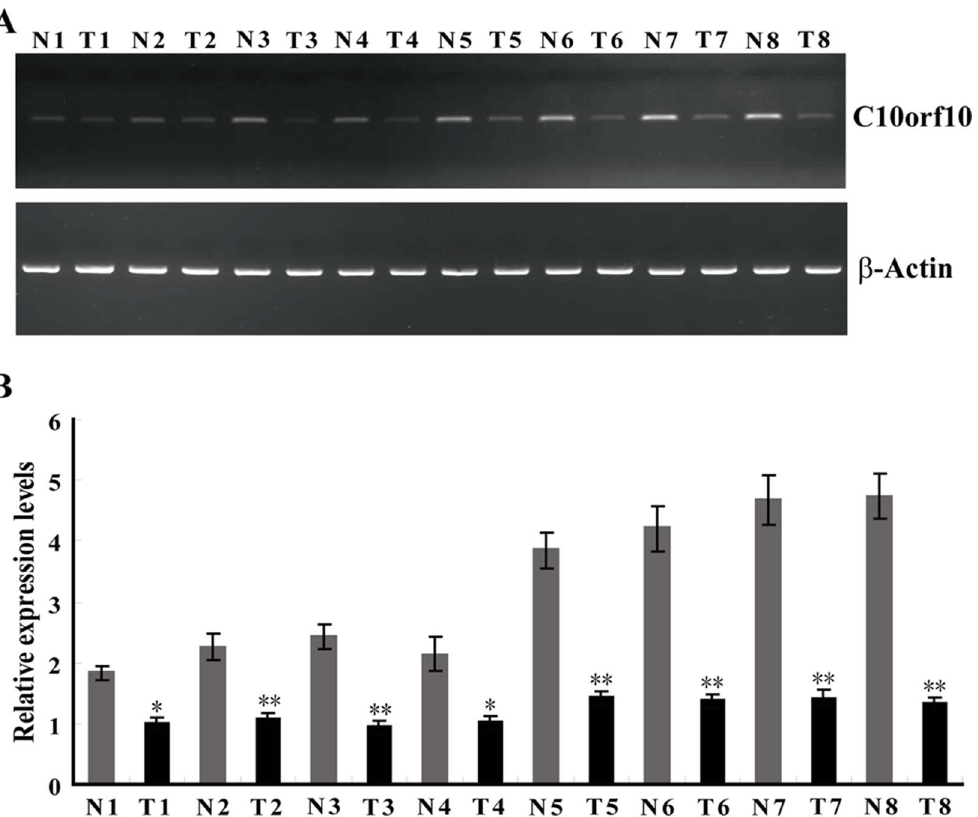
Figure 1. The mRNA expression of C10orf10 is frequently decreased in human BC tissues. (A) RT-PCR analysis of C10orf10 mRNA levels in normal breast and BC tissues. The b -actin was used as an internal control. (B) C10orf10 mRNA levels was also detected by qRT-PCR analysis in normal breast and BC tissues. The b -actin was used as an internal control. Error bars indicate s.d. (n=3).